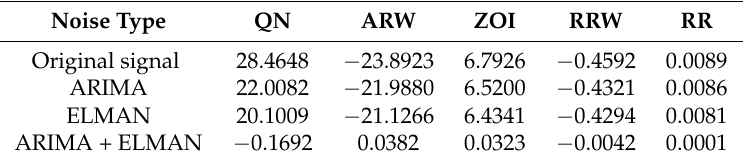
Table 2. Comparison results of coefficients before and after compensation. Here, QN indicates Quantization Noise, ARW indicates Angle Random Walk, ZOI indicates Zero Offset Instability, RRW indicates Rate Random Walk, and RR indicates Rate